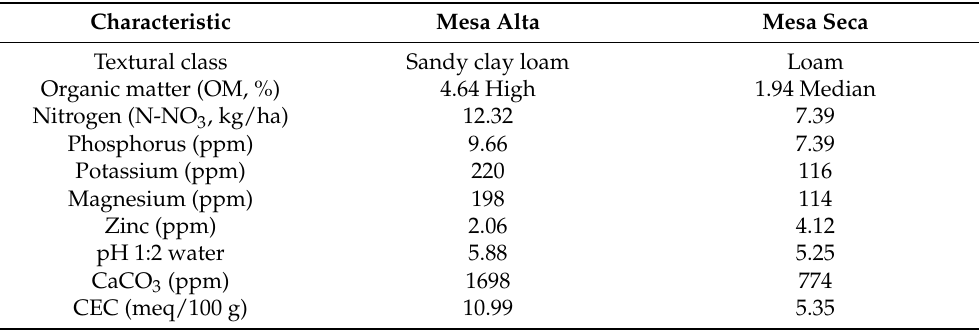
Table 1. Soil characteristics in both reciprocal trials in the municipality of Santiago Papasquiaro, state of Durango,